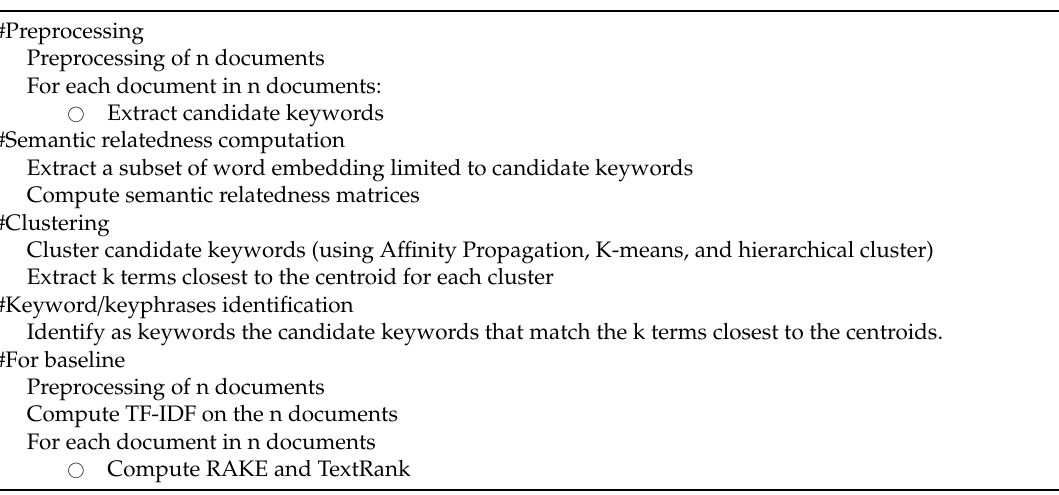
Table 3. Steps of the proposed